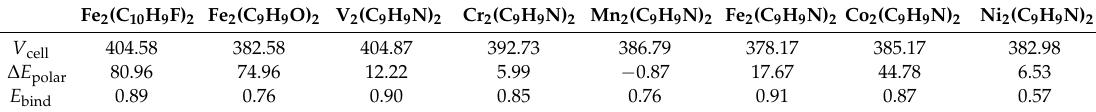
Table 5. Cell volume ( V cell , Å 3 ) at magnetic ground state, energy difference of the triclinic polar metallocenes with the FE configuration with respect to the AFE configuration ( ∆ E polar = E FE − E AFE , meV per cell), binding energy ( E bind = E molecule − E ground /2, eV per molecule).